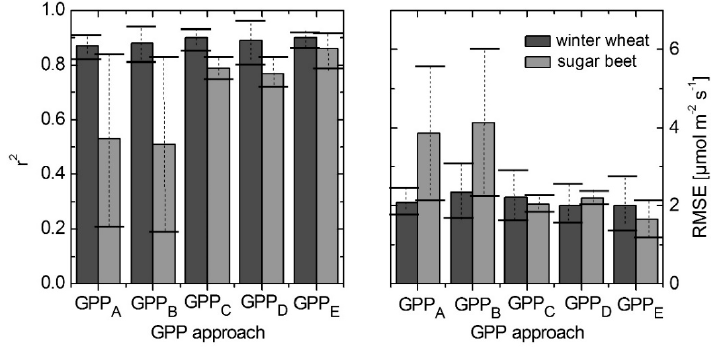
Figure 8. Mean coefficient of determination (r 2 , left ) and root mean square error (RMSE, right ) [ μ mol·m − 2 ·s − 1 ] for winter wheat ( dark grey ) and sugar beet ( light gray ) for the five different approaches to calculate GPP (GPP A –GPP E ). Vertical error bars indicate the minimum and maximum values of r 2 and RMSE for different observation days. Table 1. Statistical parameters characterizing the relation between measured GPP EC and calculated GPP (GPP A - GPP E ). The coefficient of determination (r 2 ) and the root mean square error (RMSE) [ μ mol·m − 2 ·s − 1 ] are given. Calculated GPP that matched best at each observation day according to r 2 and RMSE are listed in bold.